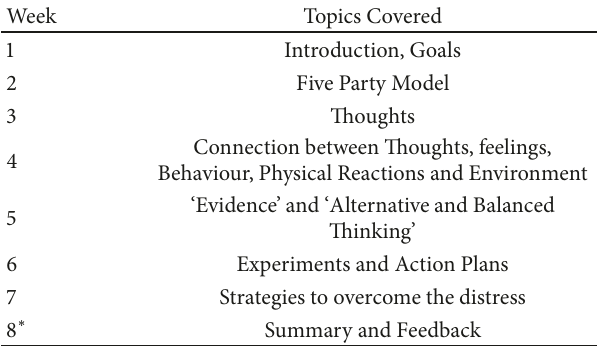
Table 1: CBT topics by week of